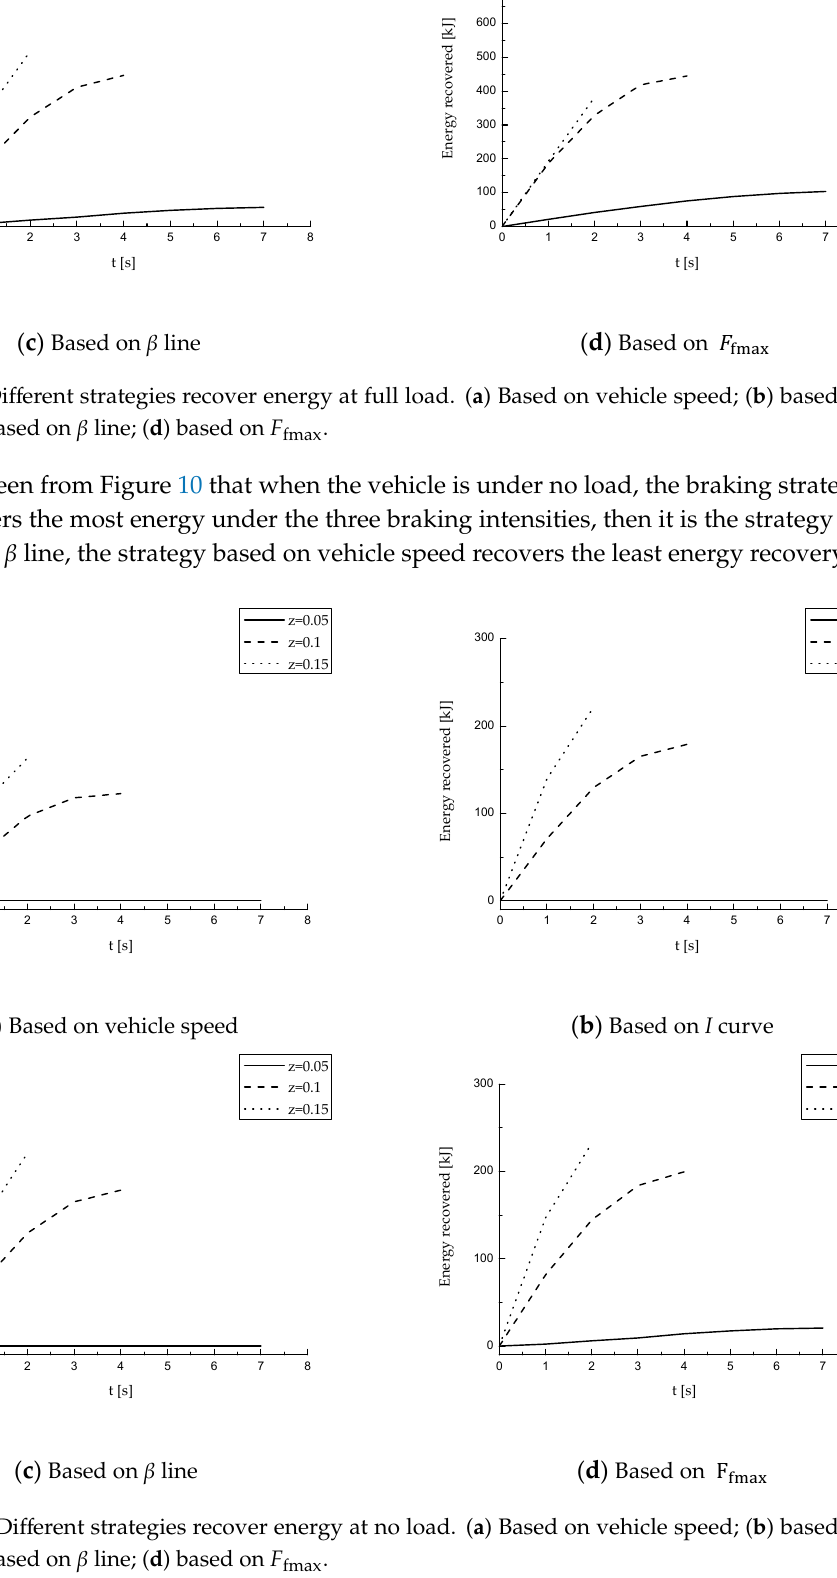
Figure 10. Di ff erent strategies recover energy at no load. ( a ) Based on vehicle speed; ( b ) based on I curve; ( c ) based on β line; ( d ) based on F fmax